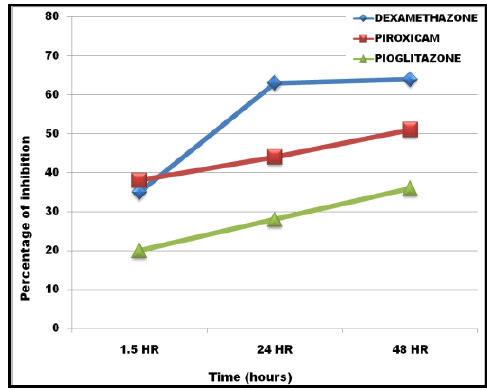
Figure 2. Effect of Pioglitazone on formalin- induced sub-acute inflammation in rats.